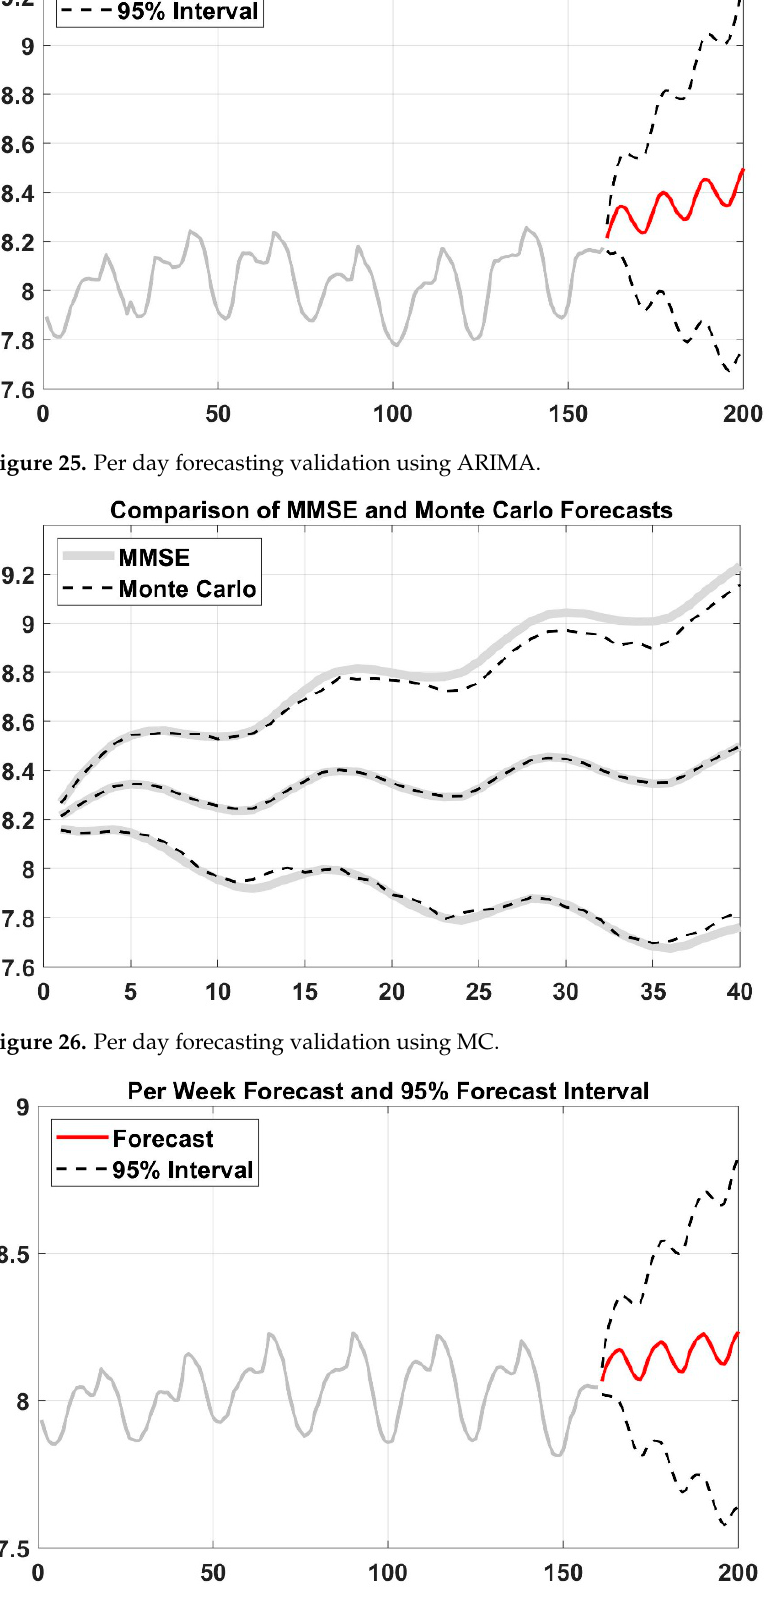
Figure 27. Per week forecasting validation using ARIMA.